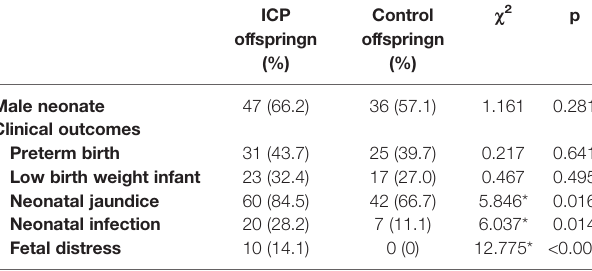
TABLE 1 | Comparison of clinical outcomes of neonates between the